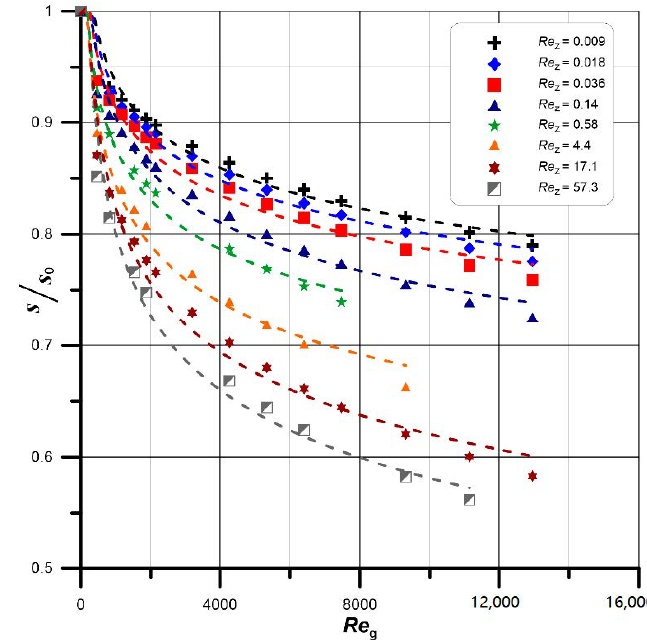
Figure 13. Influence of the gas stream on changes of the liquid film thickness in relation to the thickness occurring in gravitational flow.